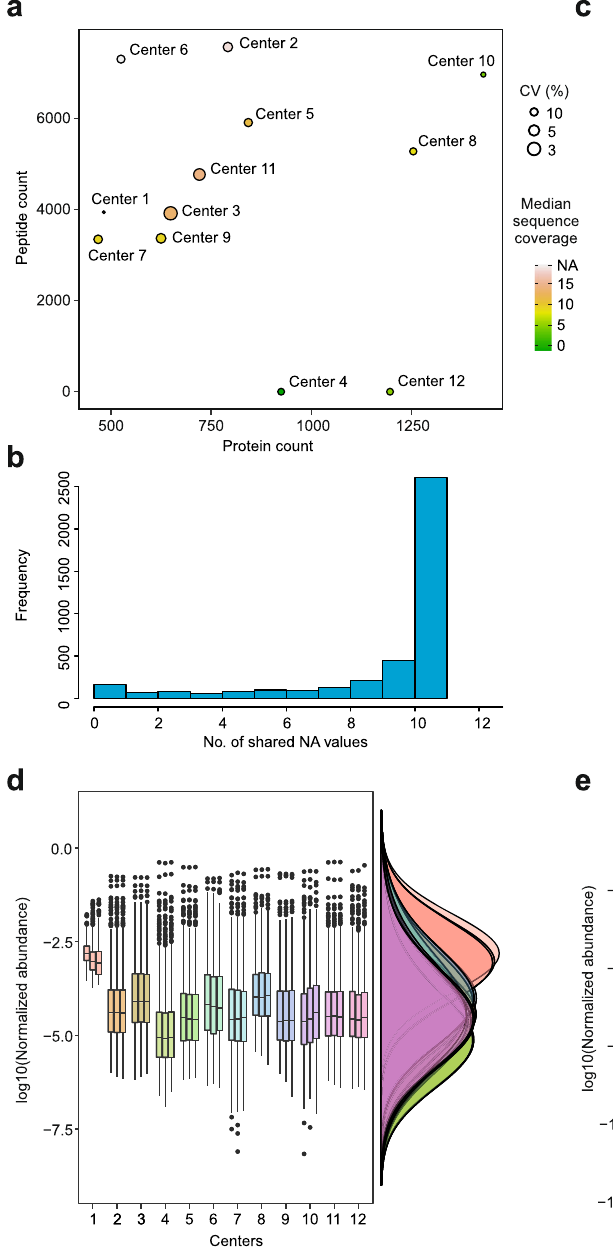
Fig. 3 | Comparative protein corona proteomics analysis by the 12 cores that provided semiquantitative protein intensity information. a Comparing the average peptide count (peptide count was not provided by cores 4 or 12), average protein count, median coef fi cients of variation CV (%) between the technical replicates and median protein sequence coverage (%) for 12 core facilities. b The number of missing values expectedly increased when data from different cores were merged. c Heatmap of 73 shared proteins with any number of peptides